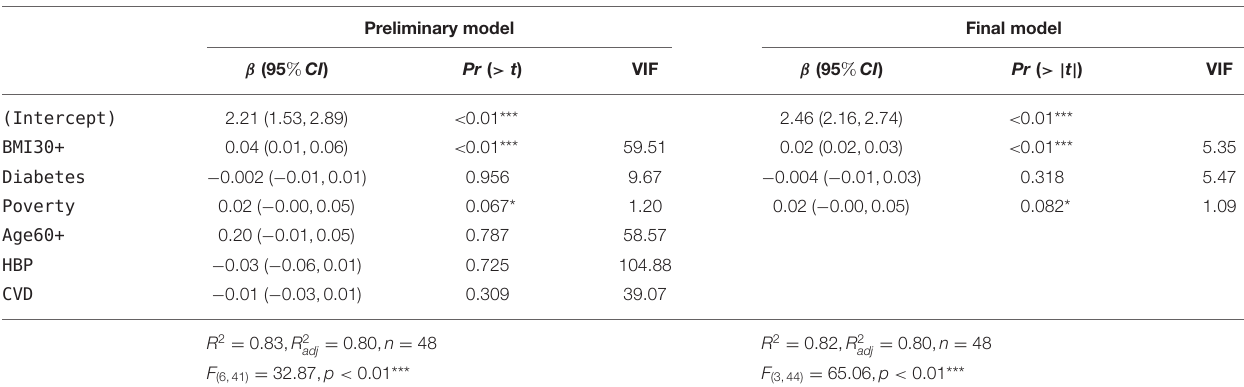
TABLE 6 | Linear models with infection and mortality rates as response variables for NHW. Linear regression models withs infection rate in NHW population as a response